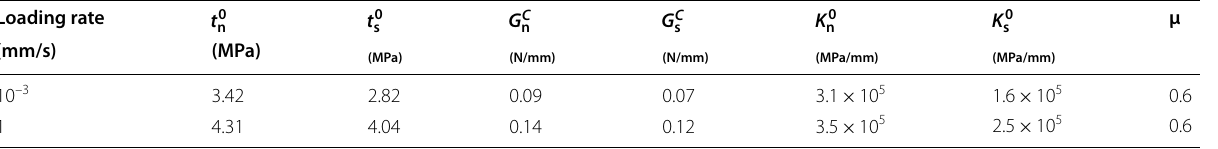
Table 3 Material parameters of cohesive elements Loading